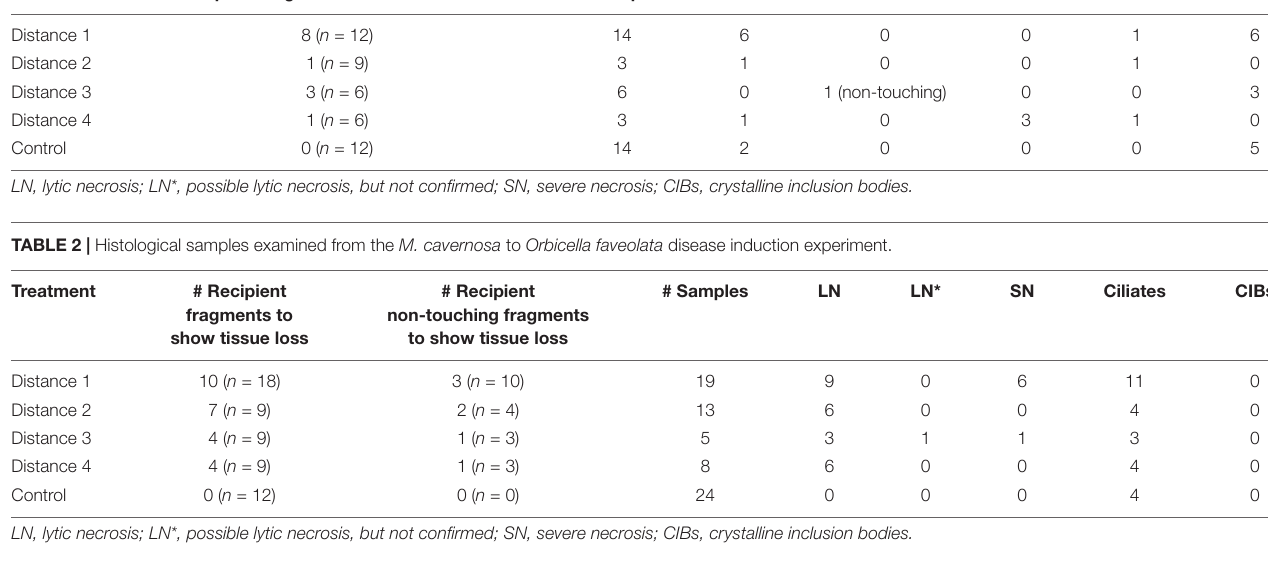
TABLE 1 | Histological samples examined during the Montastraea cavernosa to M. cavernosa disease induction experiment. Treatment # Recipient fragments to show tissue loss